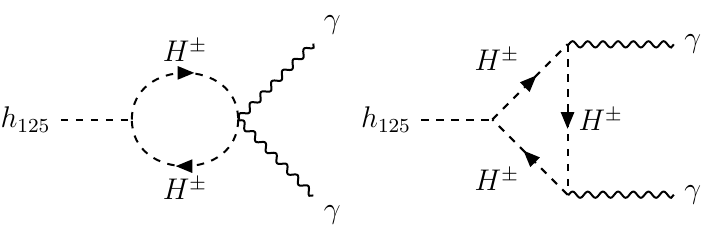
Figure 3. Charged Higgs contribution to h 125 → γγ at the one-loop